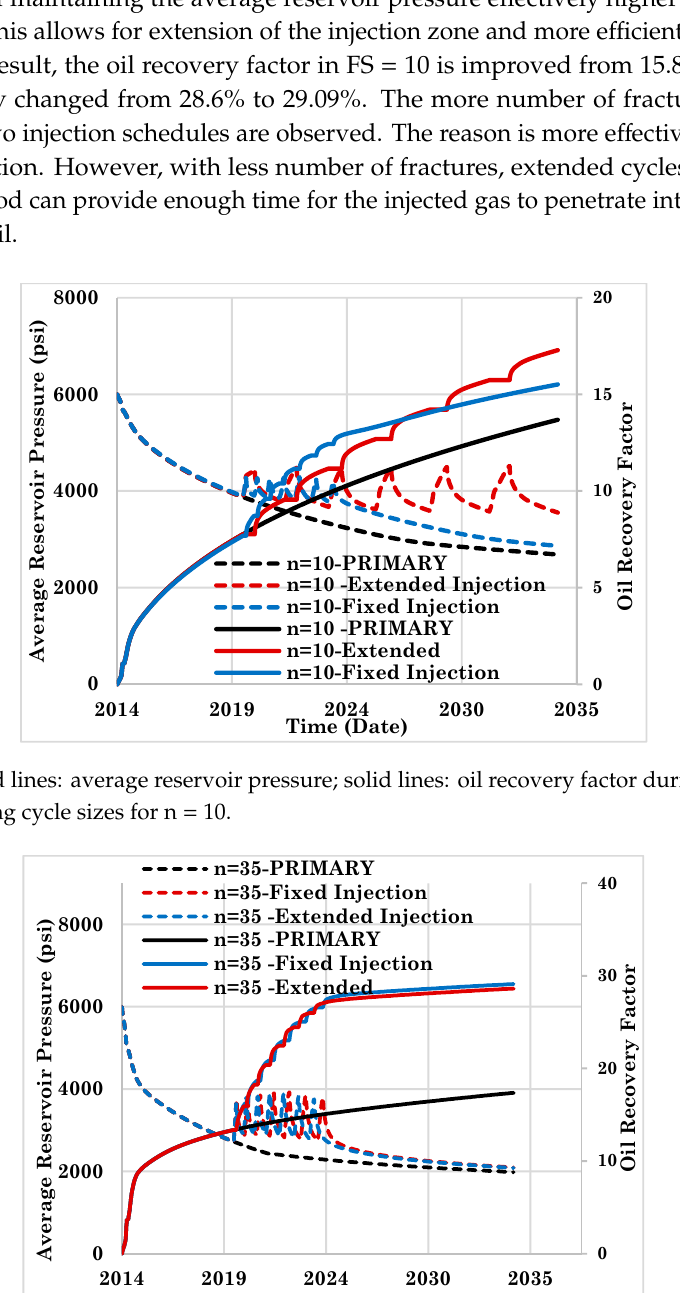
Figure 2. Primary (natural depletion) recovery factor at different number of fracture stages.